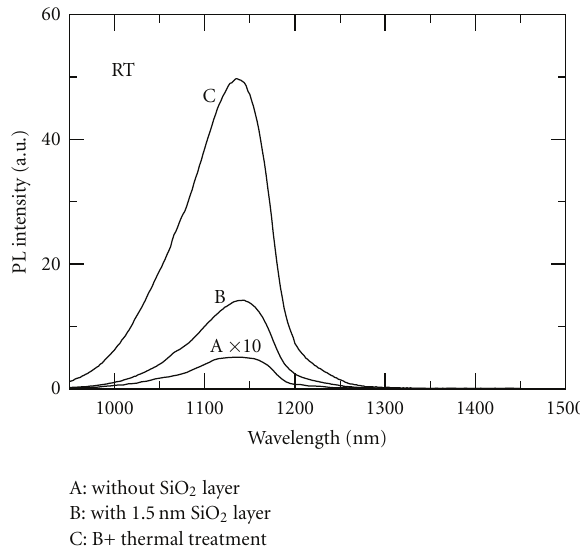
Figure 4: PL spectra of three n-type Si substrates (A–C) at room temperature. Substrates A and B have a SiO 2 layer on the surfaces with nominal thickness of 0 and 1.5nm, respectively, and substrate C is that of B after thermally treated at 820 ◦ C for 1 hour in an Ar